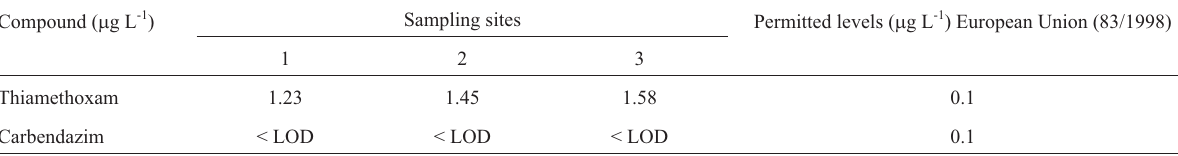
Table 2 - Results of organic compounds in the Água Boa stream water (Dourados, MS, Brazil). Compound ( (cid:2) g L -1 )